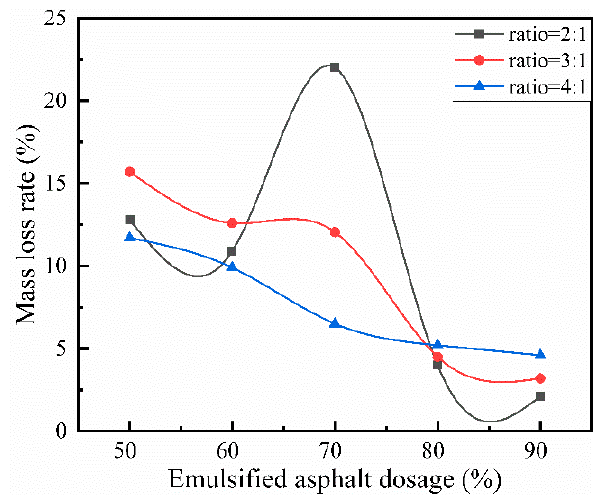
Figure 14. Mass loss rate after UV aging.